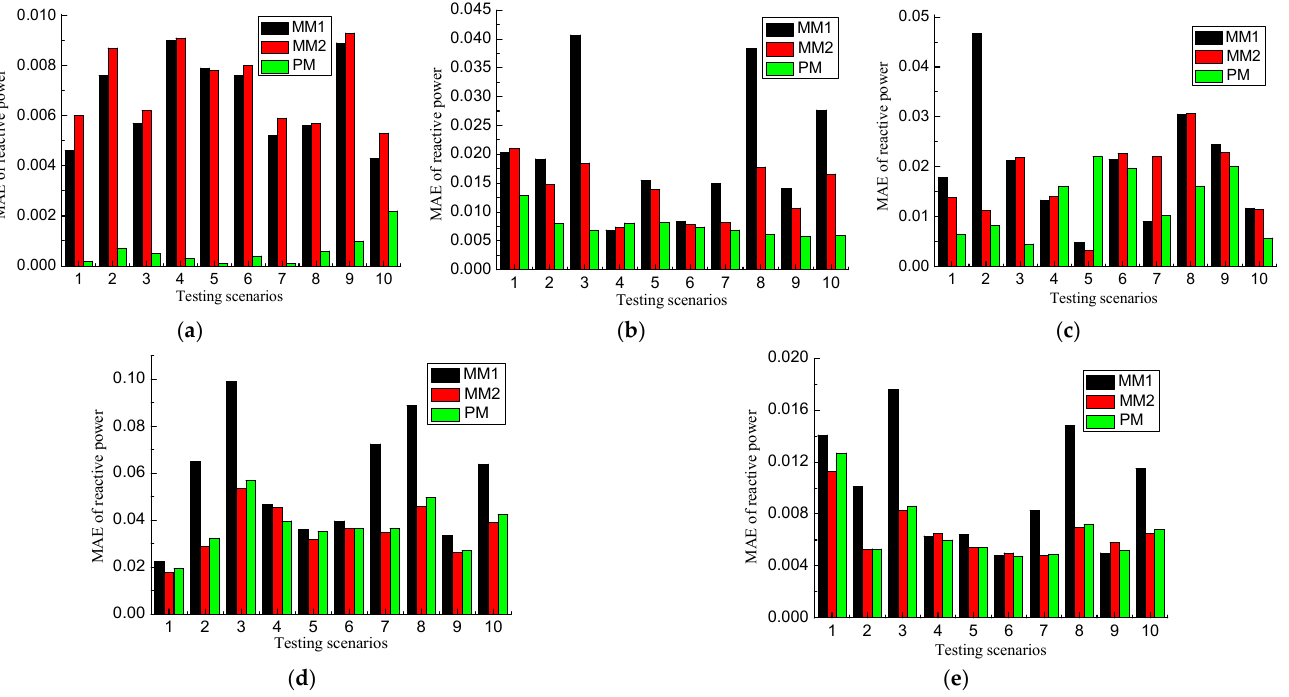
Figure 6. Reactive power response error of three equivalent models. ( a ) Pre-fault phase. ( b ) Early fault phase. ( c ) Quasi-steady-state phase during the fault. ( d ) Early fault recovery phase. ( e ) Quasi- steady-state phase during the fault recovery.